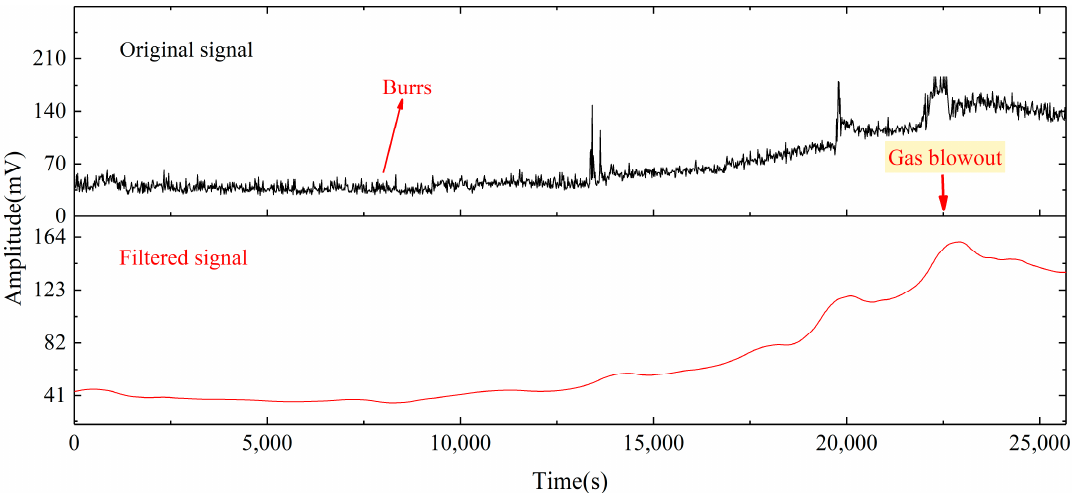
Figure 11. Comparison between the original signal and the filtered signal (AE).